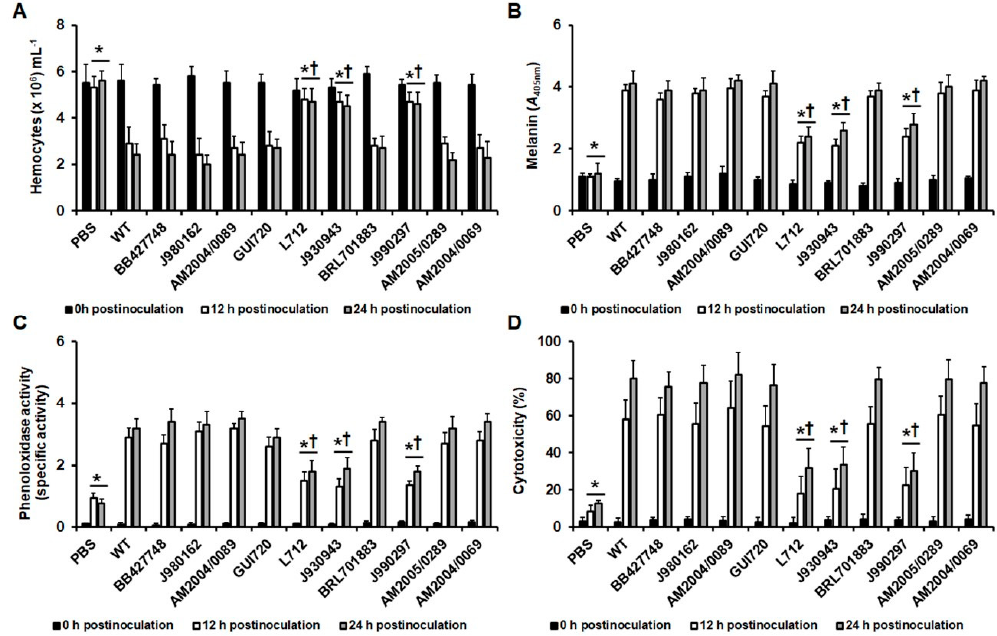
Figure 4. Quantification of hemocytes, melanin, phenoloxidase activity, and cytotoxicity in Galleria mellonella larvae infected with Candida tropicalis clinical isolates. Groups of 10 animals were infected with 2 × 10 7 yeast cells, incubated for the indicated time at 37 °C, animals were decapitated, hemolymph collected and used to quantify the hemocytes concentration ( A ), melanin production ( B ), phenoloxidase activity ( C ), or cytotoxicity ( D ). In C, the specific activity was defined as the change in the absorbance at 490 nm per one minute per one µg protein. In D, cytotoxicity was measured as the lactate dehydrogenase activity in the cell-free hemolymph. The 100% cytotoxicity corresponds to the enzyme activity quantified from lysed hemocytes. WT, strain MYA-3404. Data are plotted as means ± standard deviation of three independent experiments performed by duplicated. * p < 0.05 when compared to the values gathered at the same postinoculation time in animals infected with the WT strain. † p < 0.05 when compared to the control condition at the same postinoculation time.